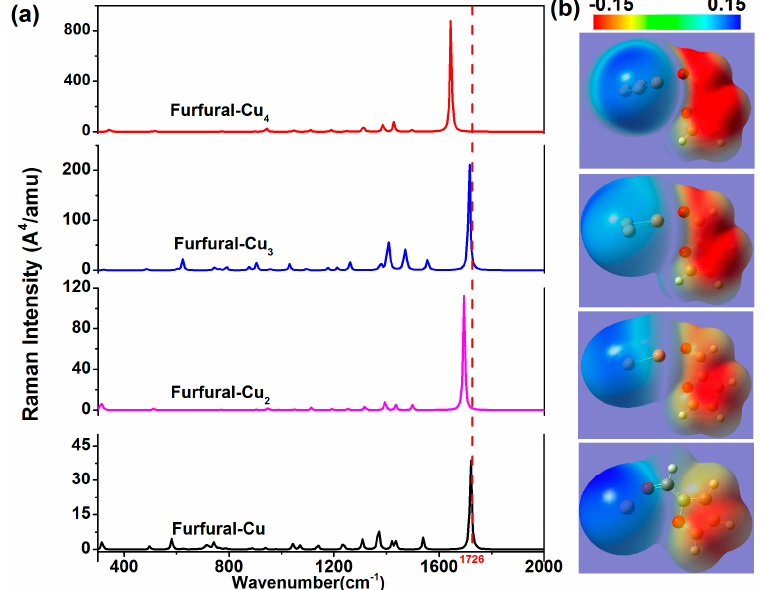
Figure 5. ( a ) The theoretical Raman spectra of furfural-Cu x complexes with different atomic numbers (red dotted lines indicate characteristic peaks 1726 cm − 1 ); ( b ) The static potential distribution of furfural-Cu x ( x = 1, 2, 3, 4).